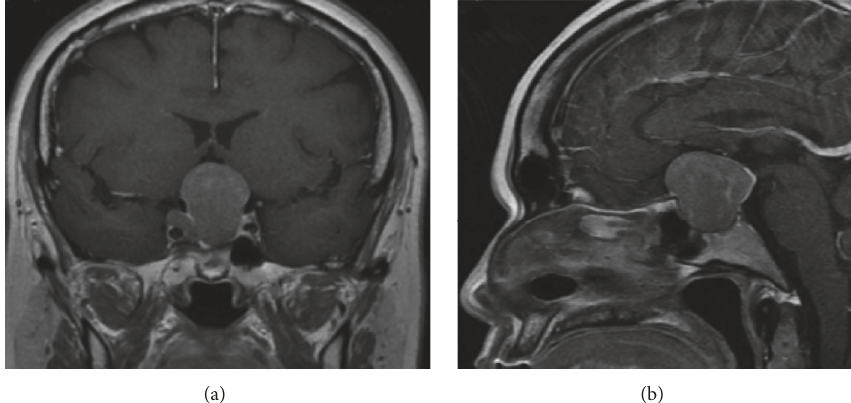
Figure 2: Coronal and sagittal MRI T1 sequence with gadolinium. Intra- and suprasellar tumor with tumor growth related to previous study.